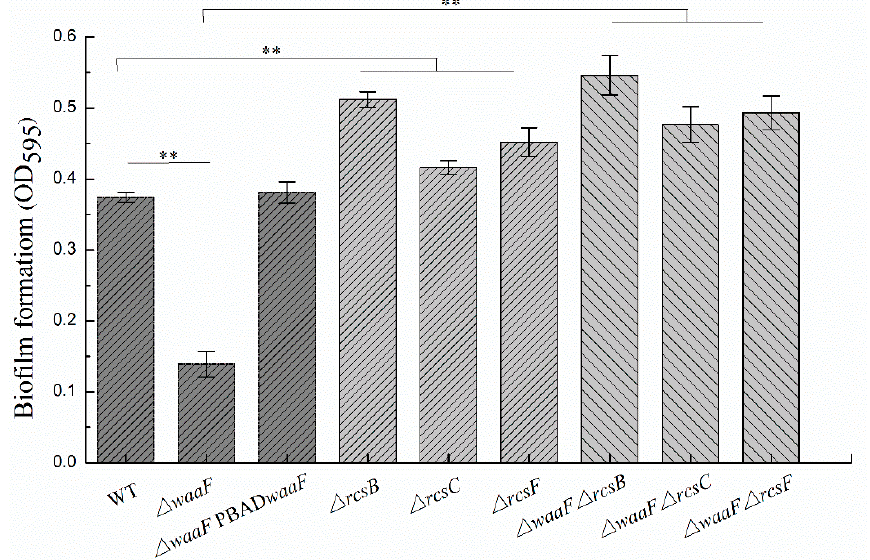
Figure 5. Changes in biofilm formation of wild-type and mutant strains of Y. enterocolitica . Y. enterocolitica was cultured in LNNS (LBNS broth diluted 1:8 in distilled water) medium supplemented with 0.6 g / L L-arabinose at 26 ◦ C. Biofilm formation was analyzed after 48 h of incubation by staining with crystal violet and measuring absorbance at 595 nm. Data are average values and standard deviations of triplicate experiments. The statistical comparison shows that there is a significant di ff erence between WT and ∆ waaF ; there is a significant di ff erence between WT and ∆ rcsF / ∆ rcsC / ∆ rcsB single mutant; there is a significant di ff erence between ∆ waaF and ∆ waaF - ∆ rcsF / ∆ waaF - ∆ rcsC / ∆ waaF - ∆ rcsB double mutant. An asterisk indicates a significant di ff erence with ** p < 0.01.